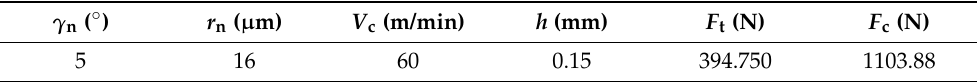
Table 5. Optimal cutting conditions for minimizing the forces.